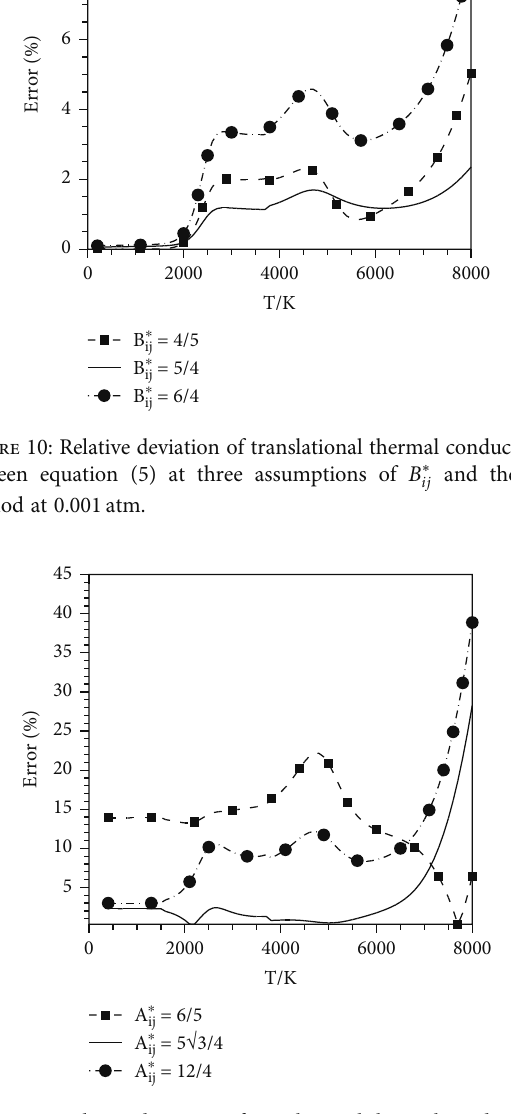
Figure 11: Relative deviation of translational thermal conductivity between equation (12) at three assumptions of A ∗ ij and the CE method at 0.001atm.